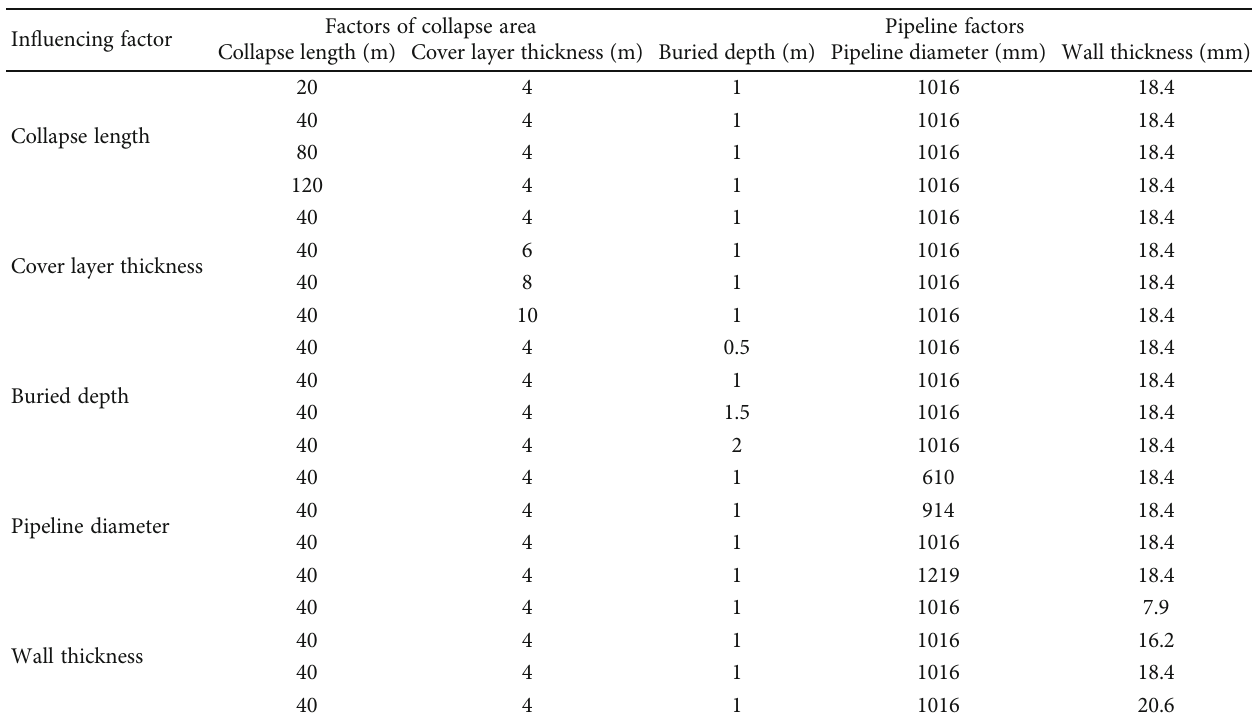
Table 3: Simulated conditions.